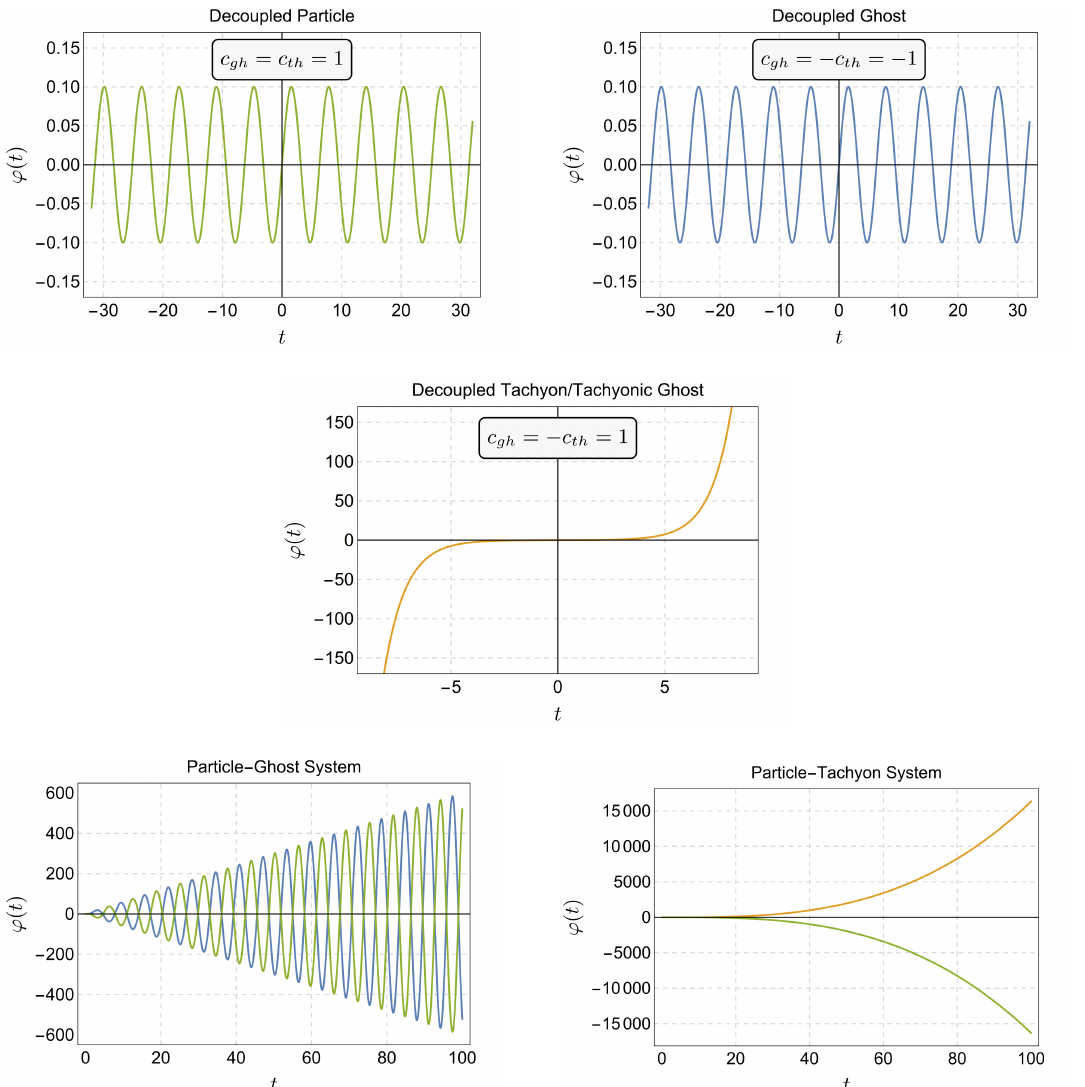
Figure 8 . Comparison of classical ghost and tachyonic instabilities in the solutions ϕ ( t ) ≡ ϕ ( t, ~q = 0) to the field equations. The green, blue, and orange lines depict the Fourier modes of particle, ghost and tachyonic fields, respectively. Non-interacting particles and ghosts (top-left and top-right panel, respectively) do not show exponentially growing modes, rather their fields oscillate periodically in time with constant amplitudes. In the case of free tachyons, there exist regimes (shown in the central panel) where the characteristic frequency ω is imaginary and the fields modes are exponentially ~q growing. The figures on the bottom refer to the case of a standard particle-field φ coupled with a ghost (left-bottom panel) and with a tachyon (right-bottom panel) via the Lagrangian (4.6). The plots have been obtained using a quartic interaction, L = − ( φ + ϕ ) 4 . Turning the ghost-particle I interaction on triggers the ghost instability, resulting in oscillatory and exponentially growing Fourier modes for both the particle and the ghost fields. Similarly, a tachyonic instability propagates into other sectors of the